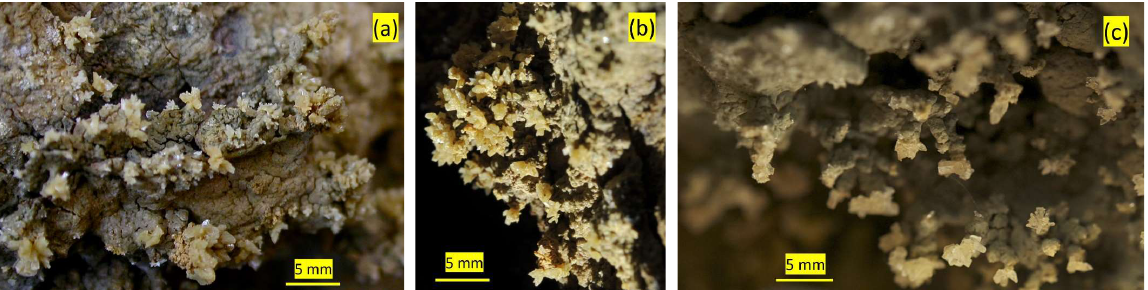
Figure 7. Photographic images taken in different years at the Stefføya site showing the formation gypsum crystals on the top of jarosite formations. The calcium needed could have originated from the water access during tidal cycles in different seasons. The same water source could also be responsible for the subsequent dissolution of gypsum in a cyclic manner in tandem with formations of jarosite. The images from left to right are taken in 2013 ( a ), 2015 ( b ) and 2009 ( c ), respectively.